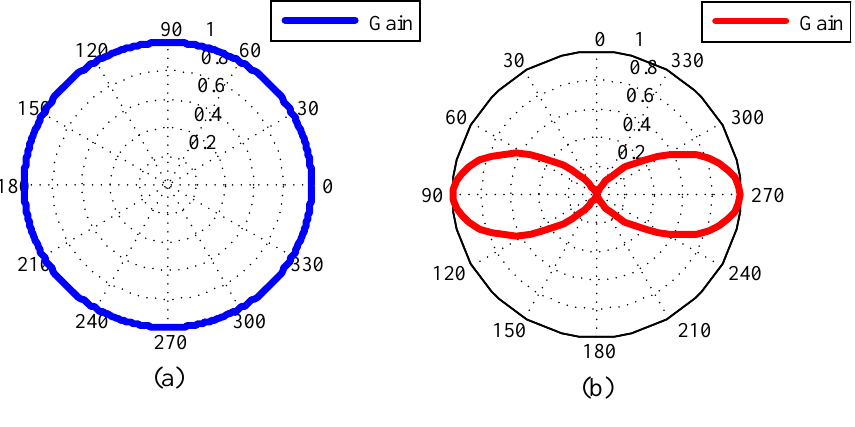
Figure 6. The radiation pattern of the antenna of s and r (a) The H-plane radiation pattern of the omnidirectional antenna utilized in the simulation. (b) The E-plane radiation pattern of the omnidirectional antenna utilized in the